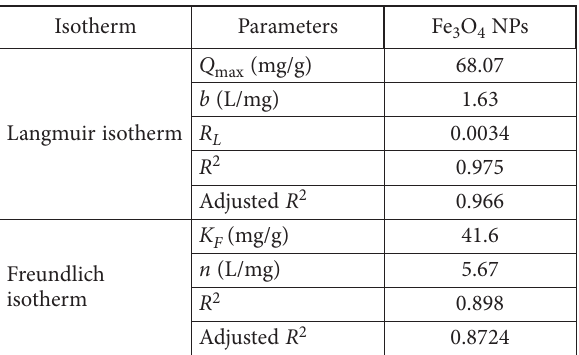
Table 3. Langmuir and Freundlich isotherm values for lead (II) adsorption on magnetic NPs